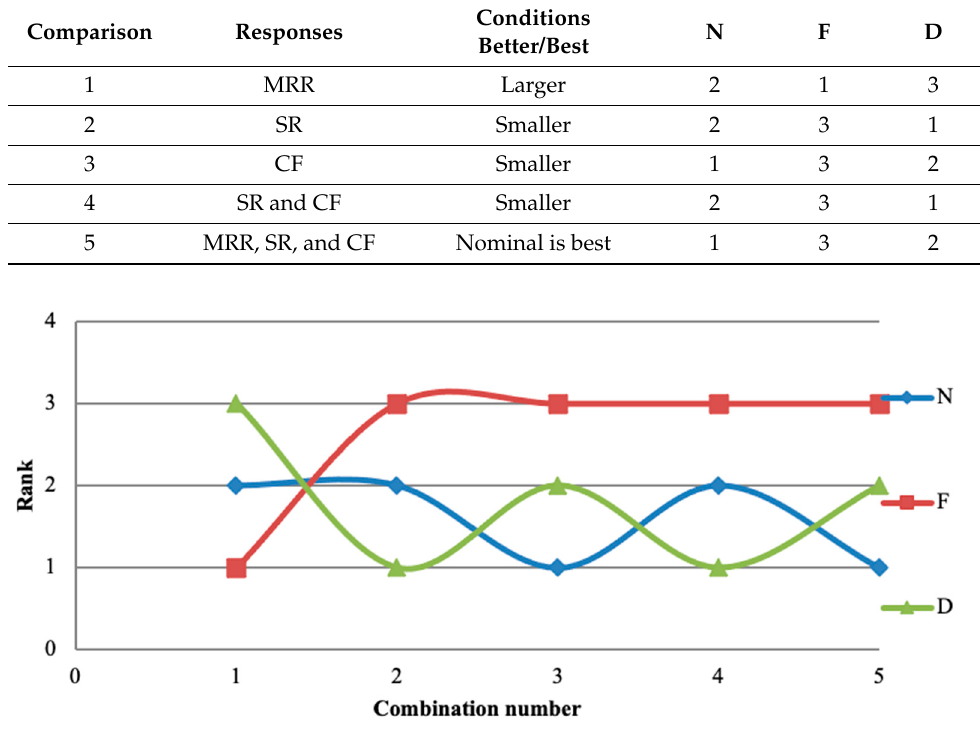
Table 9. Ranking of various combinations of responses.